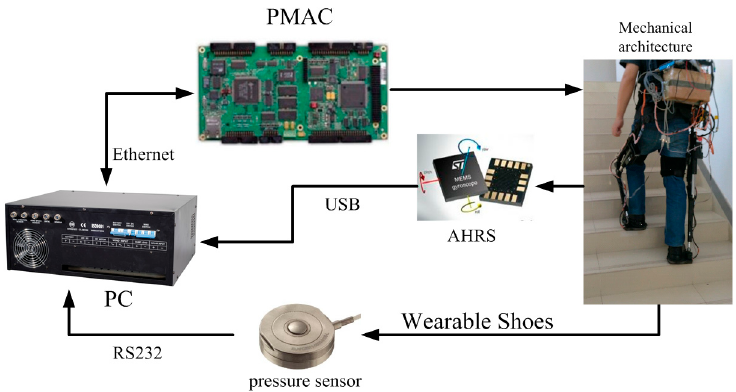
Figure 4. The signal collection structure. The measuring range of pressure sensors is 0~100 kg while that of AHRS sensors is − 180°~180° in the sagittal plane.